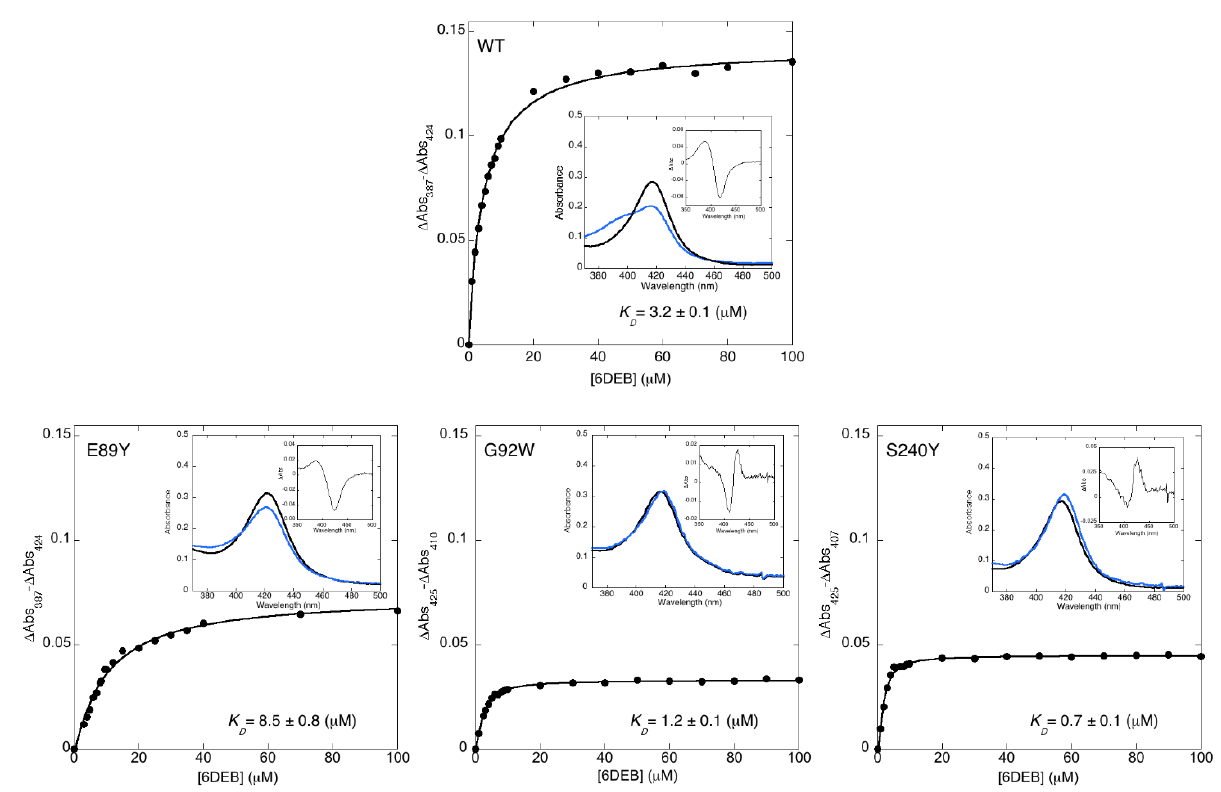
Figure 2. Binding of 6DEB to OleP mutants. Titration plots with hyperbolic fits, from which the dissociation constants ( K D ) for 6DEB were derived. Data refer to the absorbance monitored at 298 K using a constant concentration of OleP in 50 mM Hepes and 200 mM NaCl, pH 7.5. Insets: Spectral changes induced by 6DEB in the WT and mutants OleP, respectively. Black and light blue spectra were recorded before and after equilibrium titrations, with the final 6DEB concentration of 100 µ M. Right small insets are difference spectra recorded after the addition of 6DEB (final concentration 100 µ M). OleP wild type-6DEB binding data are taken from